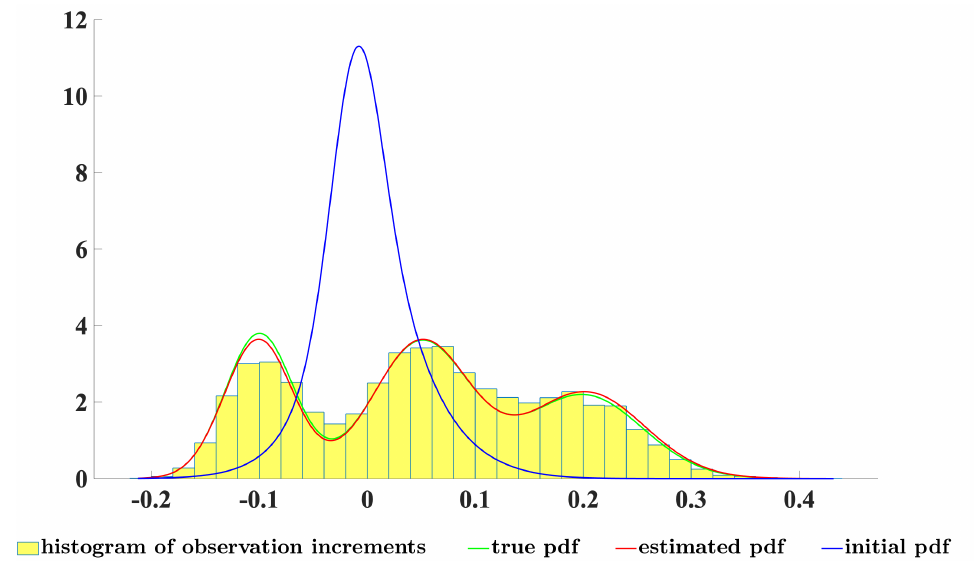
Figure 7. The true pdf of discretized observations, its histogram and